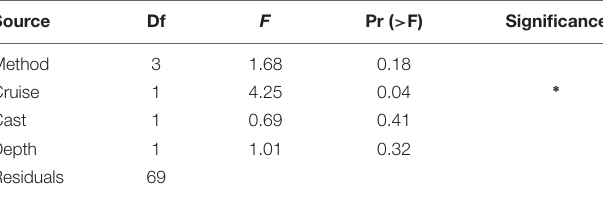
TABLE 3 | Results of the 4-way (type II) ANOVA testing for significance of treatment by method, cruise (or season), cast, and depth for log10-transformed.